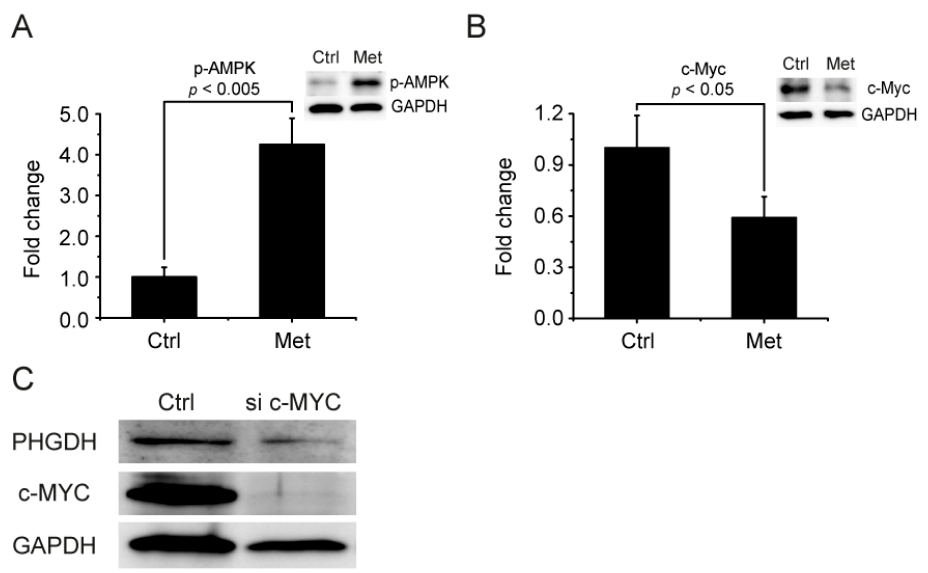
Figure 5. Metformin inhibits PHGDH through the AMPK-MYC pathway. ( A ) Changes in ( A ) p-AMPK and ( B ) c-MYC levels by metformin treatment were measured by Western blot. ( C ) The effect of c-MYC siRNA on PHGDH was estimated by Western blot.